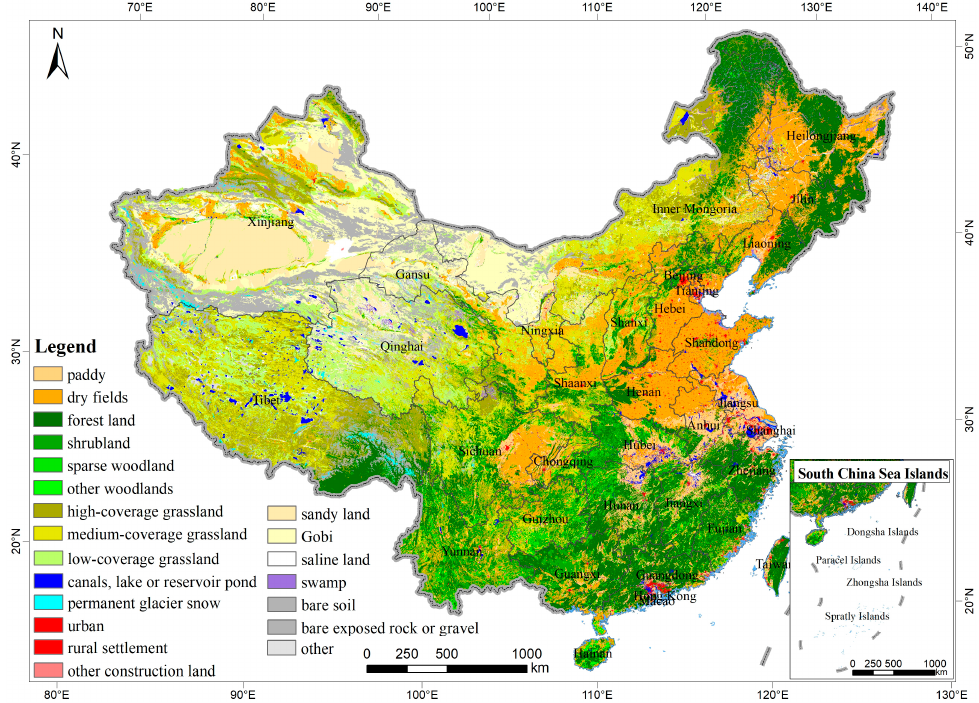
Figure 1. Spatial distribution of China’s land